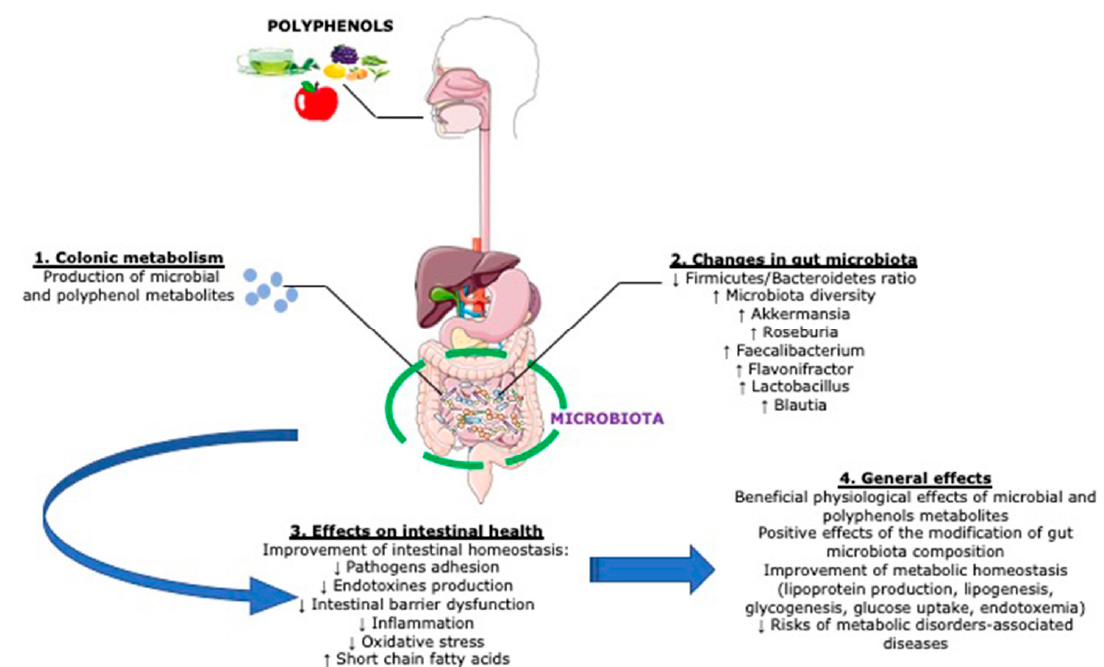
Figure 2. Beneficial actions resulting from the interaction between polyphenols and intestinal microbiota. Polyphenolic compounds exhibit prebiotic ability, which modifies bacterial composition and function. On the other hand, intestinal microbiota ameliorates intestinal homeostasis and cardiometabolic health by producing polyphenolic metabolites. * Created with Servier Medical Art.